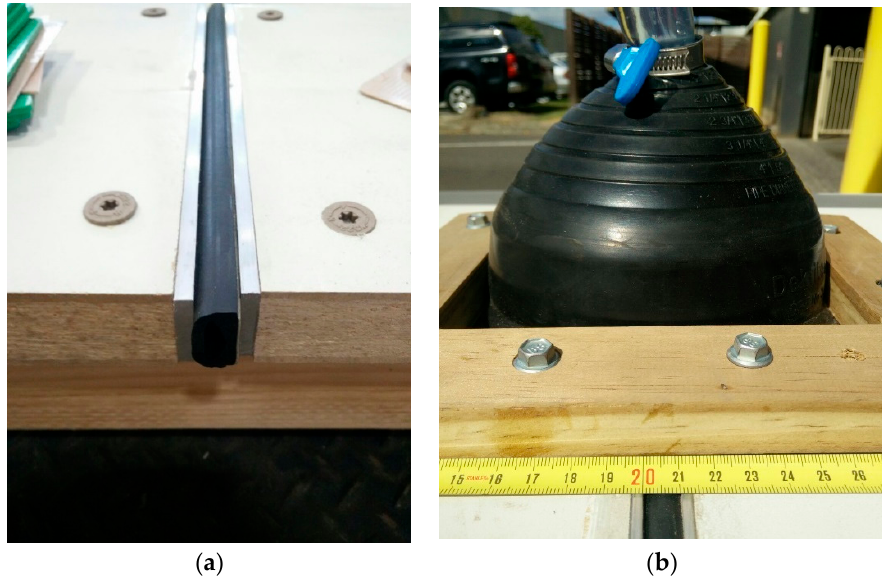
Figure 15. Gasket Seal Water Penetration Testing ( a ) EPDM rubber gasket seal between testing panels; ( b ) A rubber boot seal to distribute water pressure to the gasket.